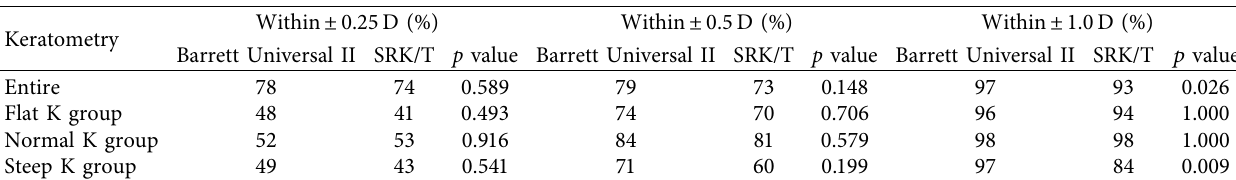
Table 3: The percentages within ± 0.25, ± 0.5, and ± 1.0D of the targeted refraction using the Barrett Universal II and the SRK/Tformulas. Keratometry